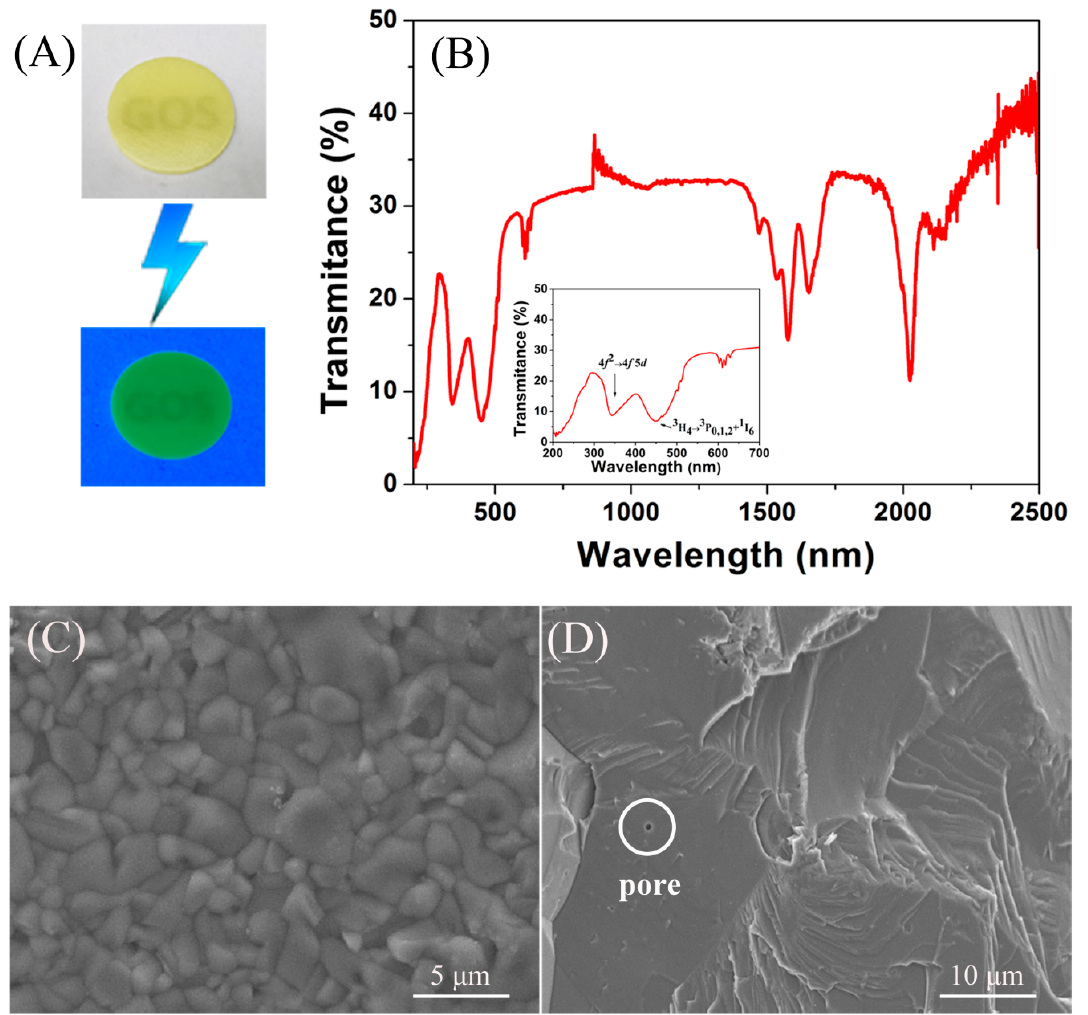
Figure 3. Appearance ( A ) and in-line transmittance ( B ) of the GOS:Pr ceramic scintillator, and SEM micrographs of the surface ( C ) and fracture surface ( D ) of the sintered ceramic. The lower part in panel ( A ) is the appearance of GOS:Pr ceramic under irradiation from a 254 nm UV lamp. The inset in panel ( B ) is the enlargement of its in-line transmittance curve from 200 to 700 nm.